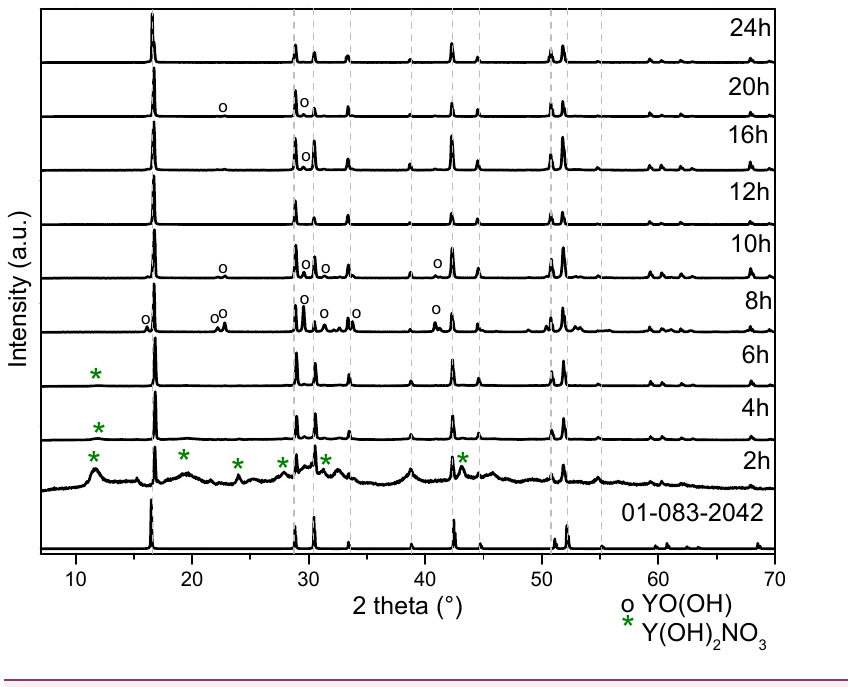
Figure 3 XRD patterns of Y(OH) 3 obtained from 2 to 24 h of reaction. Full-size DOI: